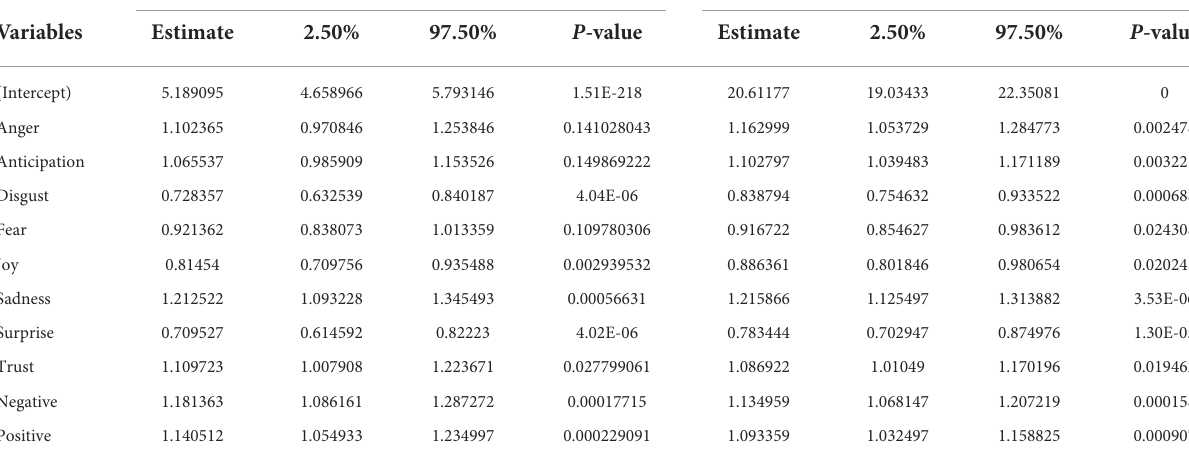
TABLE 2 Estimates (confidence intervals) from negative binomial regression